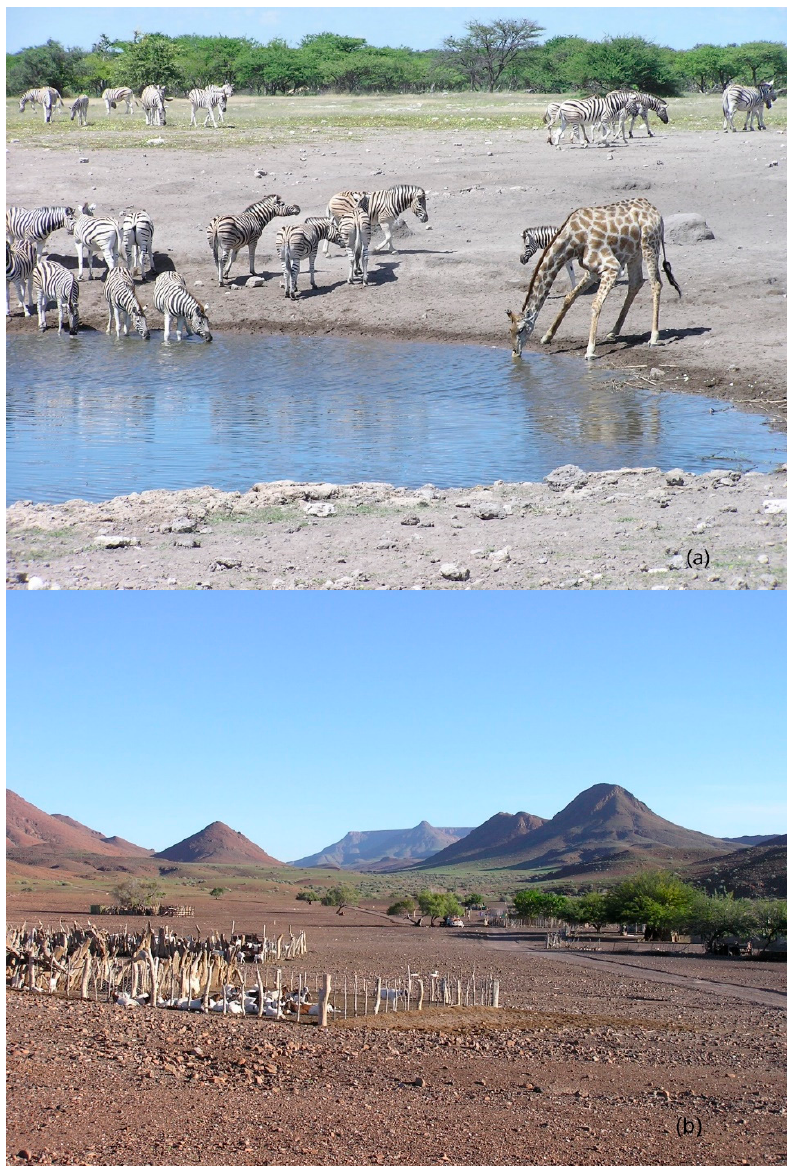
Figure 1. ( a ) Example of a piosphere created by trampling and grazing in Etosha National Park, Namibia. ( b ) Example of heavy trampling and grazing impact of livestock leading to denuded vegetation in Damaraland, Namibia (Images: D.B. Croft).